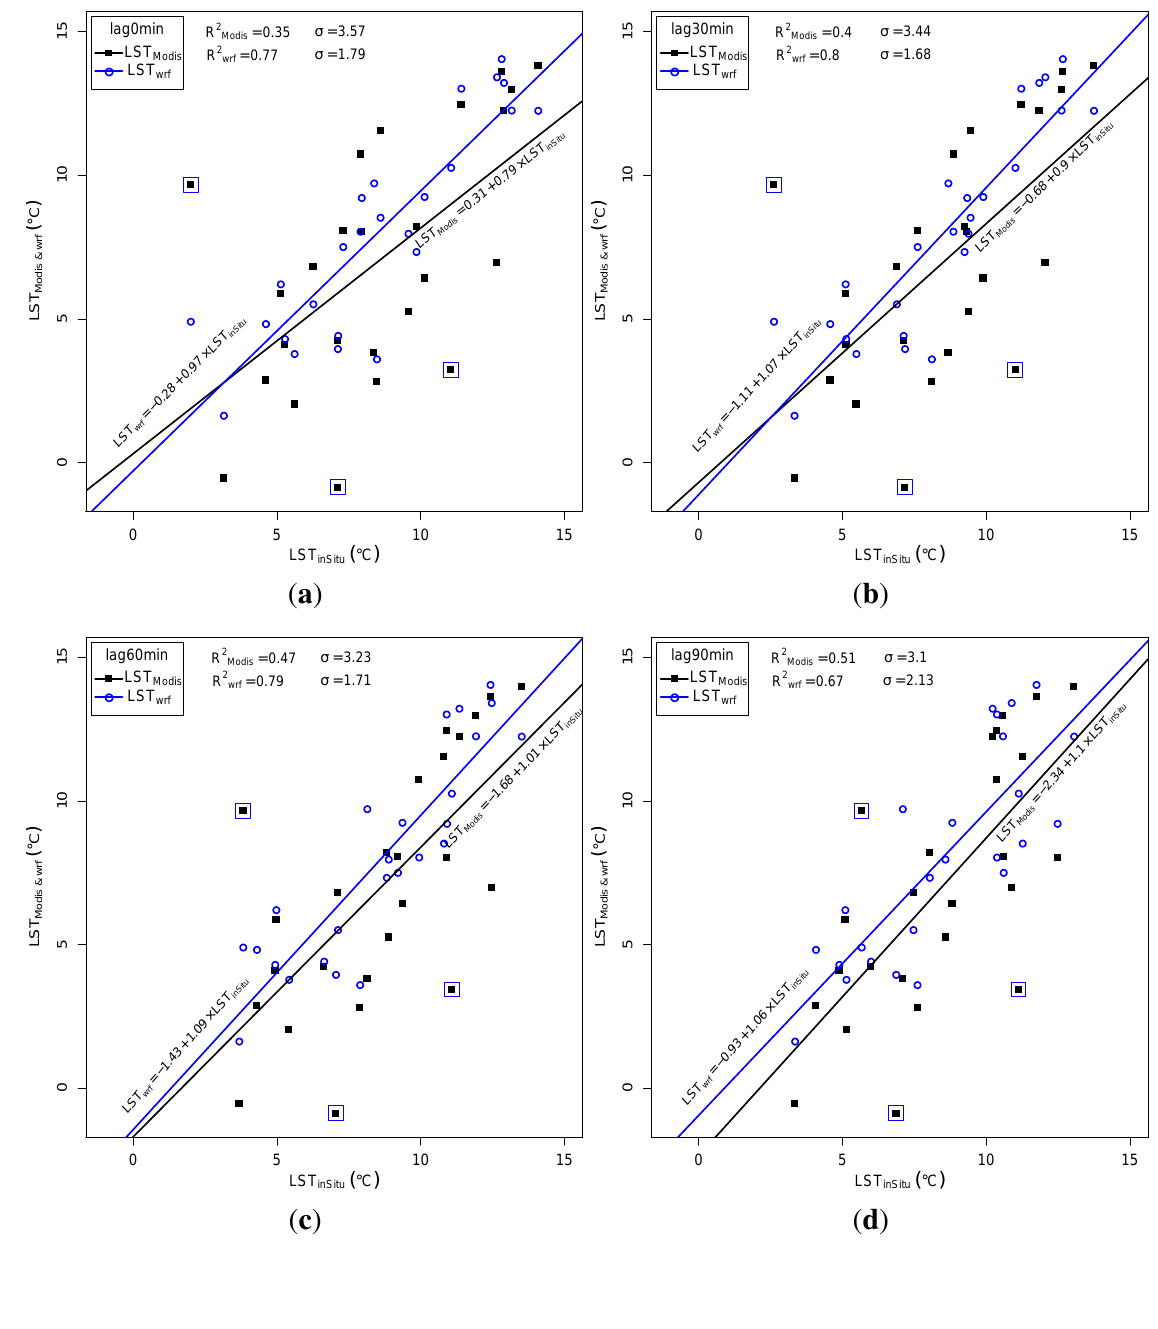
Figure 10. Scatterplots with line-fits of LST all observations (outliers are bordered by a larger square), second row: outliers